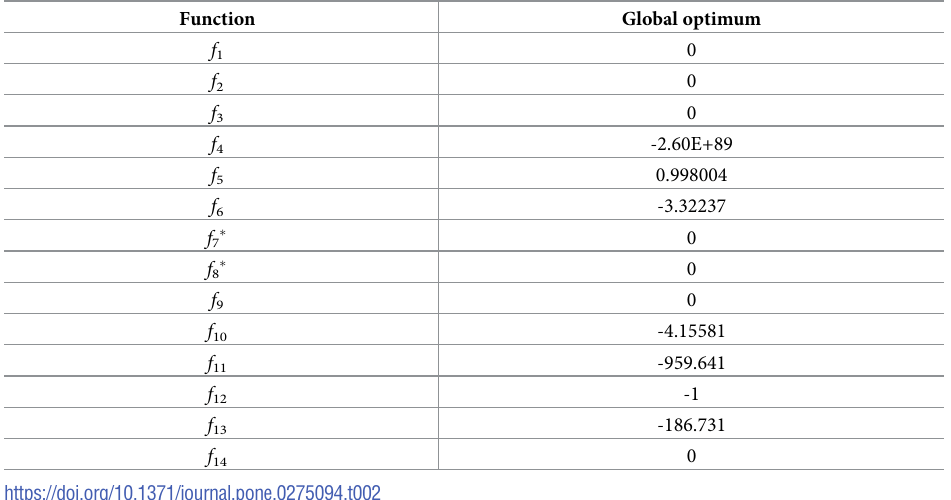
Table 2. Global optima for objective functions f 1 – f 14